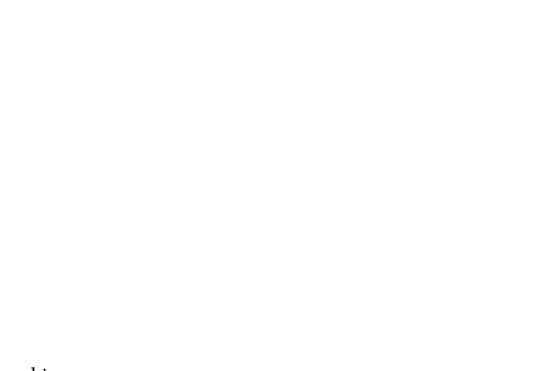
Table 1. Decomposition of annual electricity demand